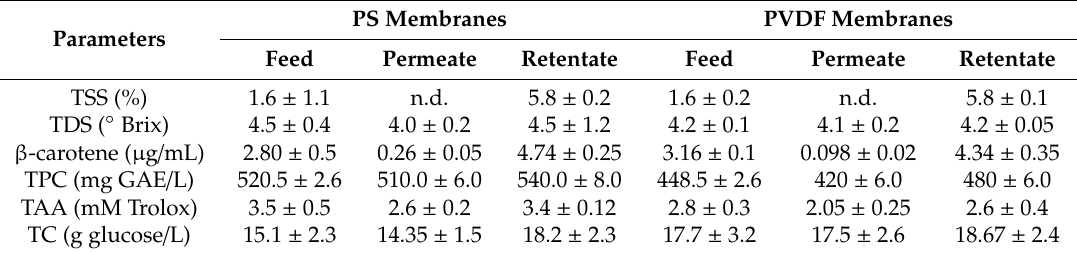
Table 1. Chemical composition of Goji berry extract clarified by hollow fiber membranes. Parameters